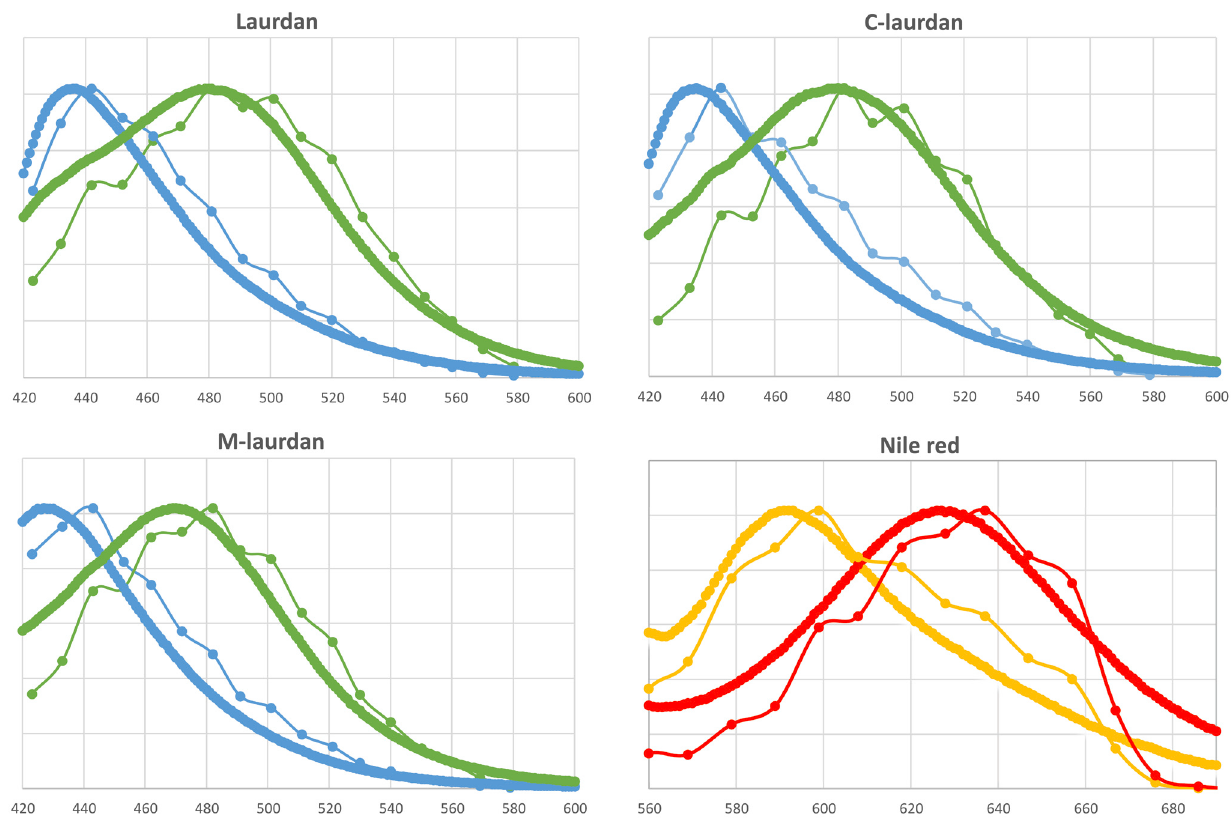
Figure 5. Emission curves obtained with the biphoton microscope are very similar to those obtained on a standard spectrofluorimeter. The four fluorescent lipid probes were inserted into either Lo or Ld MLVs and their emission curves were recorded in cuvettes on a spectrofluorimeter (thick lines), or imaged on the biphoton microscope in the same conditions as used for live cells. After defining appropriate ROIs in the lambda stacks, the emission curves of individual MLVs were extracted using the ImageJ software. The thin lines correspond to the average curves obtained from 6–10 separate MLVs (the error bars are smaller than the symbols). Lo, DPPC–chol MLVs (blue or orange); Ld, DOPC MLVs (green or red).